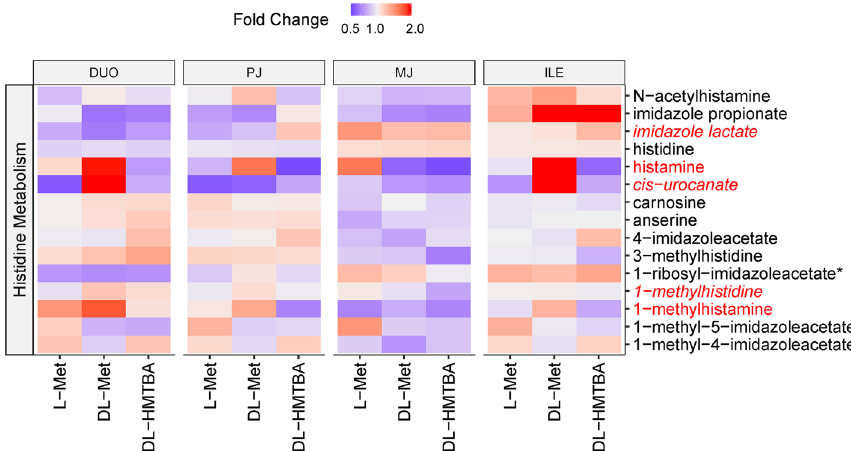
Figure 7. Heat map of the histidine metabolism pathway, showing the distribution of all measured pathway- related metabolites along duodenum (DUO), proximal jejunum (PJ), middle jejunum (MJ) and ileum (ILE) in pigs pre-fed with L-Met, DL-Met or DL-HMBTA. Blue color indicates lower abundance whereas red color indicates higher abundance of metabolites. Red writing of individual metabolites indicates a treatment effect or, if combined with italics, a region × treatment interaction ( P < 0.10).